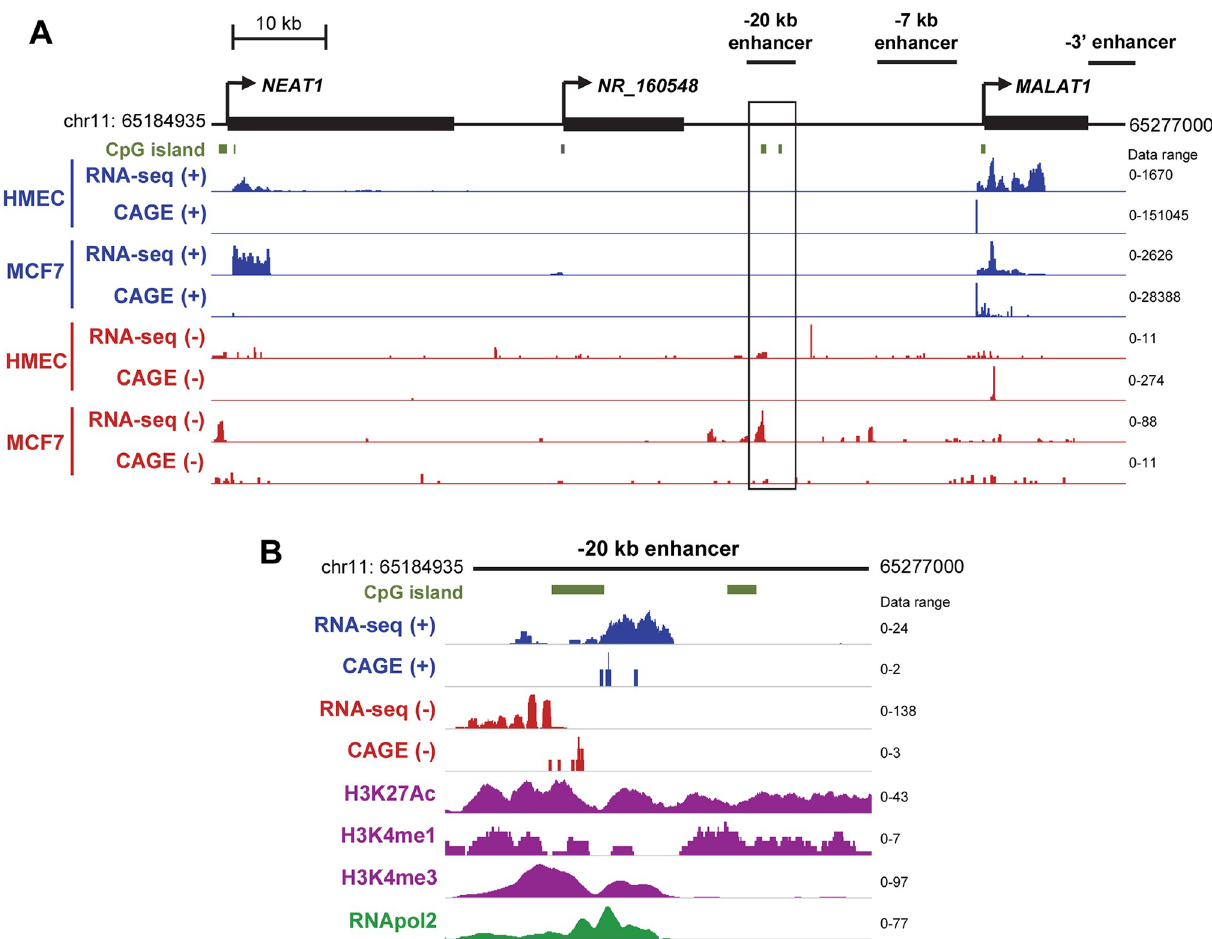
Fig 1. The MALAT1– 20 kb enhancer is actively transcribed in breast cancer cells. ( A ) Bulk RNA-seq and CAGE data for normal (HMEC) and cancerous (MCF7) breast cell lines. Normalized tag counts are indicated for each row, with blue tracks corresponding to plus strand signal and red tracks corresponding to negative strand signal. RNA-seq and CAGE data were downloaded from ENCODE. ( B ) Close-up view of the MALAT1– 20 kb enhancer in MCF7 cells. Note that different data ranges were set for each mark to display the close-up view of the peaks.